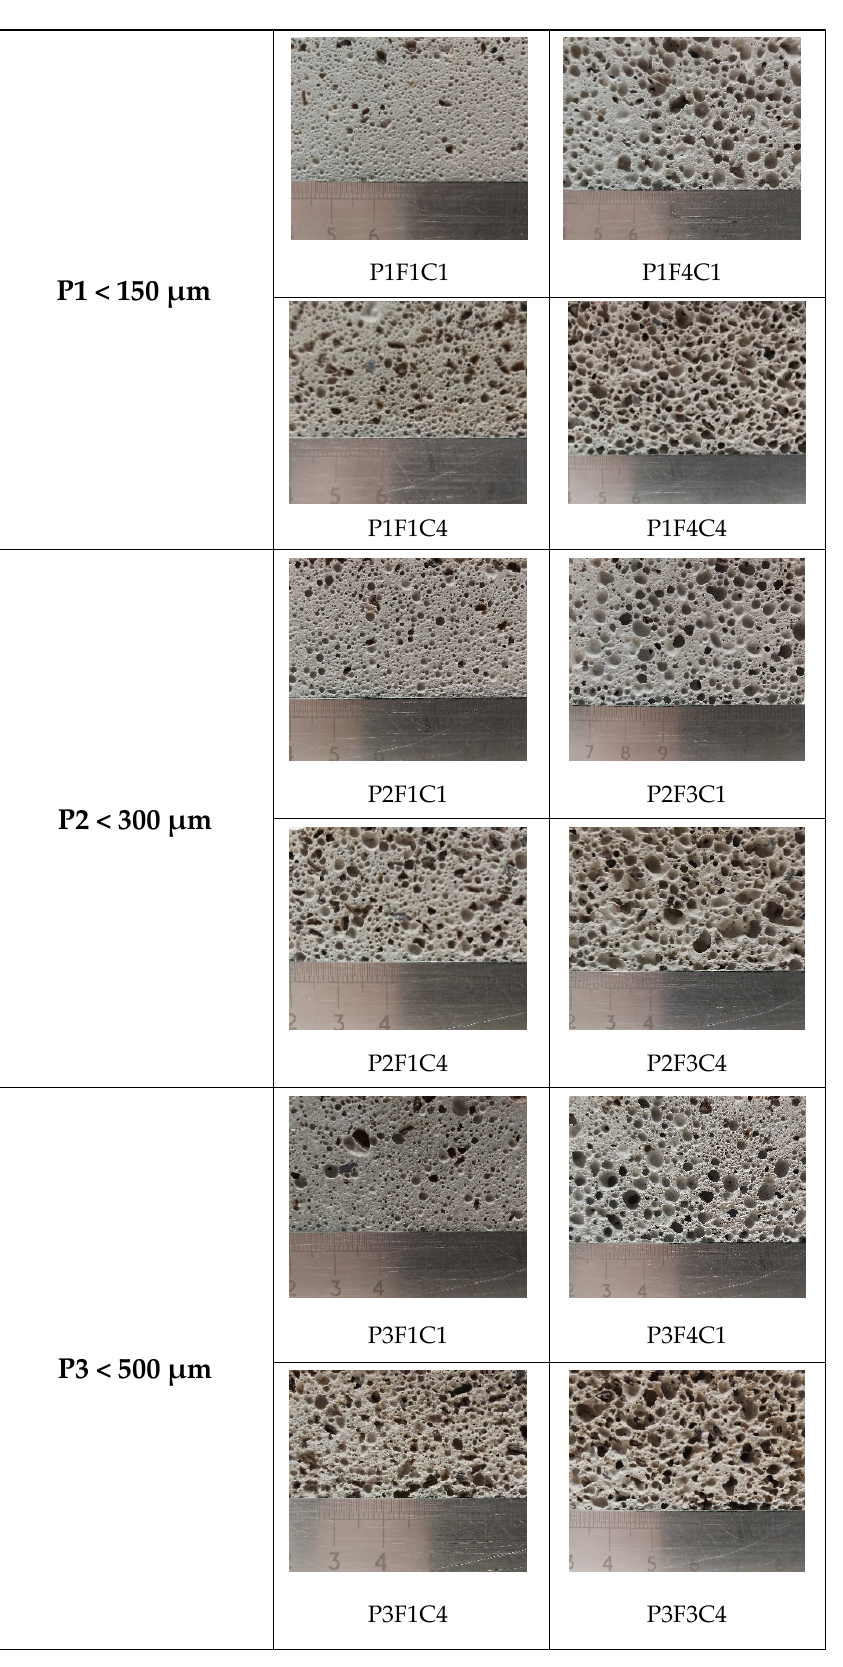
Figure 8. Photographs of the samples’ central foam section with a small (0.009 w.%) and large (0.05 w.%) amount of Al powder